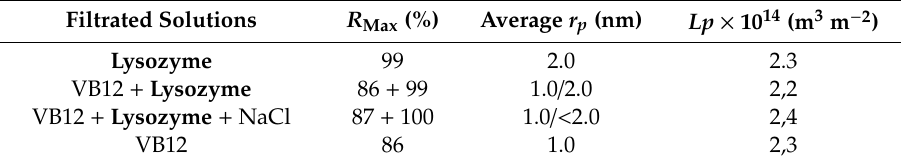
Table 3. Filtration tests of solute